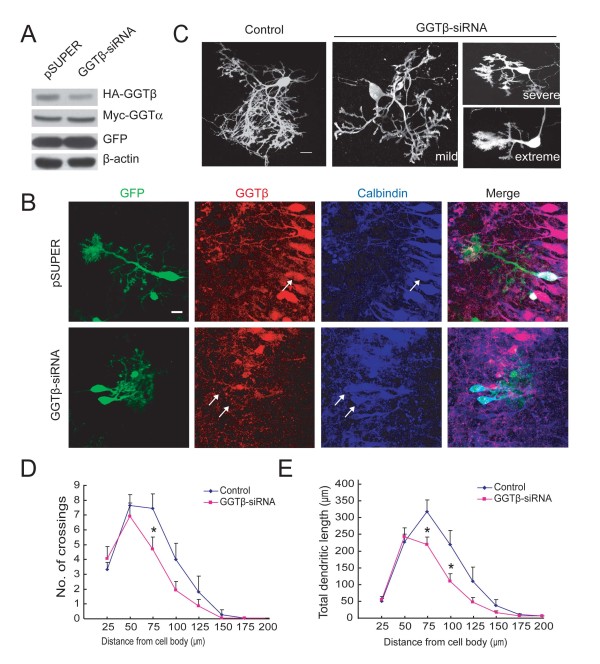
Down regulation of GGTβ decreases dendrite growth and branching of PCs. A) HEK293 cells were co-transfected with Myc-GGTα and HA-GGTβ, together with pSUPER-GGTβ-siRNA or pSUPER. Cell lysates were subjected to IB with HA, Myc, GFP, or β-actin antibodies. B) Cultured cerebellar slices were transfected with pSUPER or pSUPER-GGTβ-siRNA, followed by staining with antibodies against GGTβ and Calbindin. Note the decrease of GGTβ signals in GGTβ-siRNA -transfected PCs. Scale bar = 20 μm. C) Cultured cerebellar slices at DIV2 were transfected with pSUPER-GGTβ-siRNA or pSUPER, together with pCAG-EYFP plasmid (3:1) to mark transfected cells. Shown are representative images at DIV5. Scale bar = 20 μm. D) Quantification for the number of crossings between dendrites and circles with a radius of indicated distance. E) Quantification for total dendritic length in indicated fields. Data shown are presented as means ± SEM (n = 17 for control, n = 23 for GGTβ-siRNA). *P < 0.05, Student's t test. Scale bar is 20 μm.